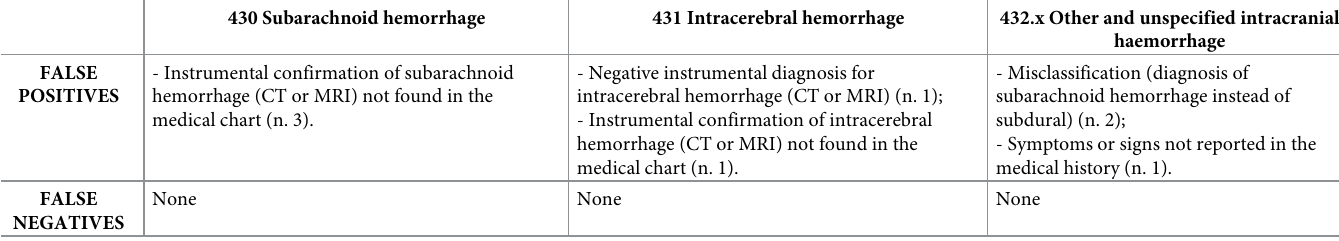
Table 9. Hemorrhagic stroke: reasons for incorrect identification of cases and controls. 430 Subarachnoid